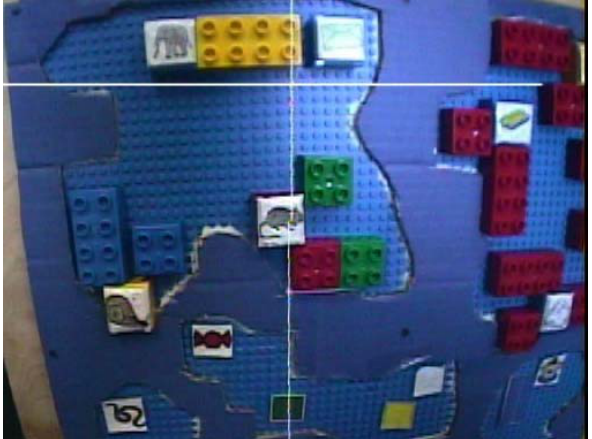
Figure 5. Partial view of the display for the eye-tracked participant, approximately half-way through the task. The cross-hair represents the eye-tracked participant’s